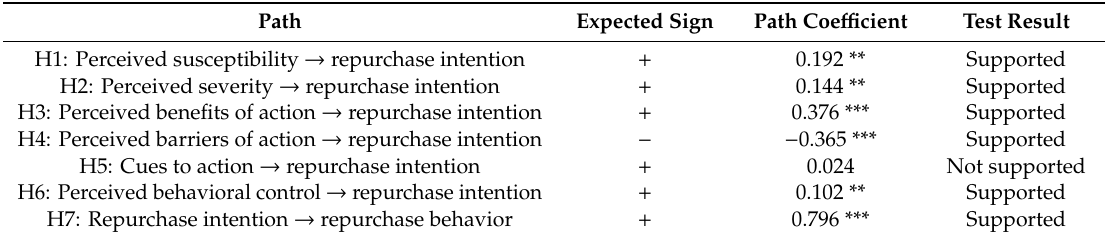
Table 5. Path coe ffi cients and hypothesis testing